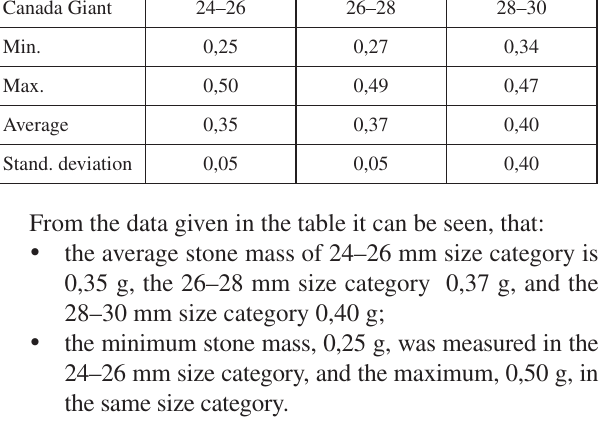
Table 5. The average values for the individual stone mass (g) Canada Giant